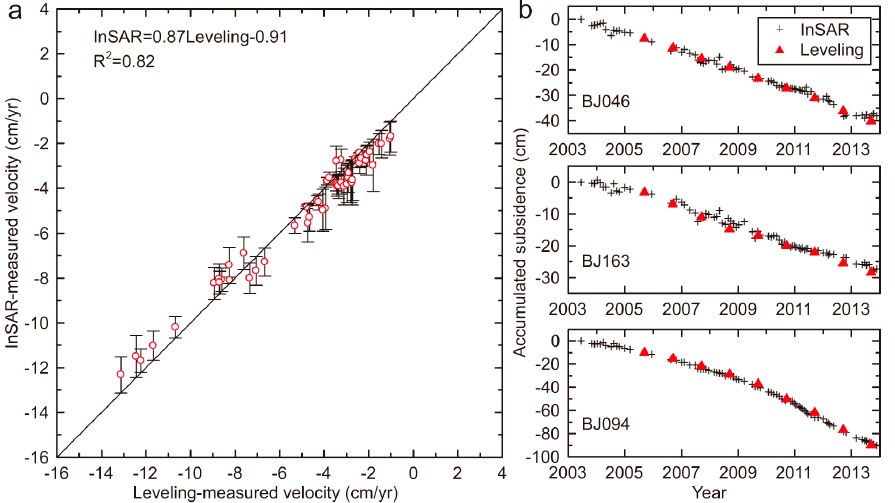
Figure 5. Comparison of InSAR and ground leveling-derived velocities during 2003–2013: ( a ) the black line represents the one-to-one function; and ( b ) comparison between the time series subsidence measured by InSAR and by ground leveling surveys at the benchmarks “BJ046”, “BJ163”, and “BJ094”.